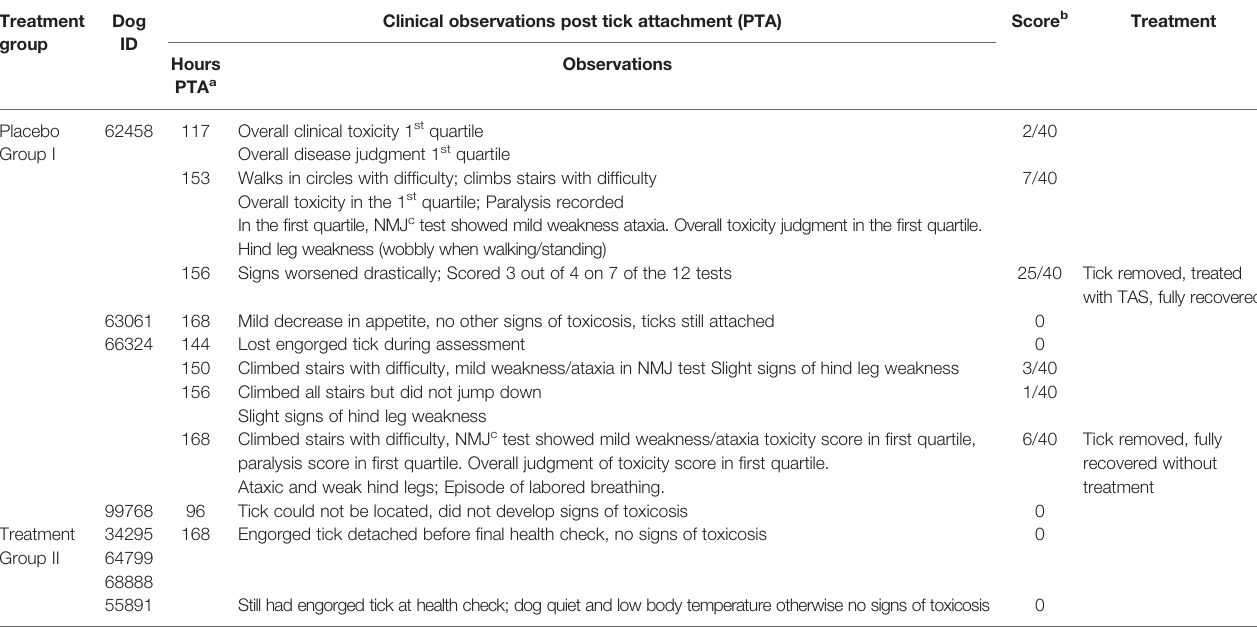
TABLE 3 | Trial 2 clinical data for cocktail vaccine HT1, HT2, HT4, HT8, HT11, HT12, HT14 and HT17 as the cocktail immunization compared to the placebo group. Treatment group